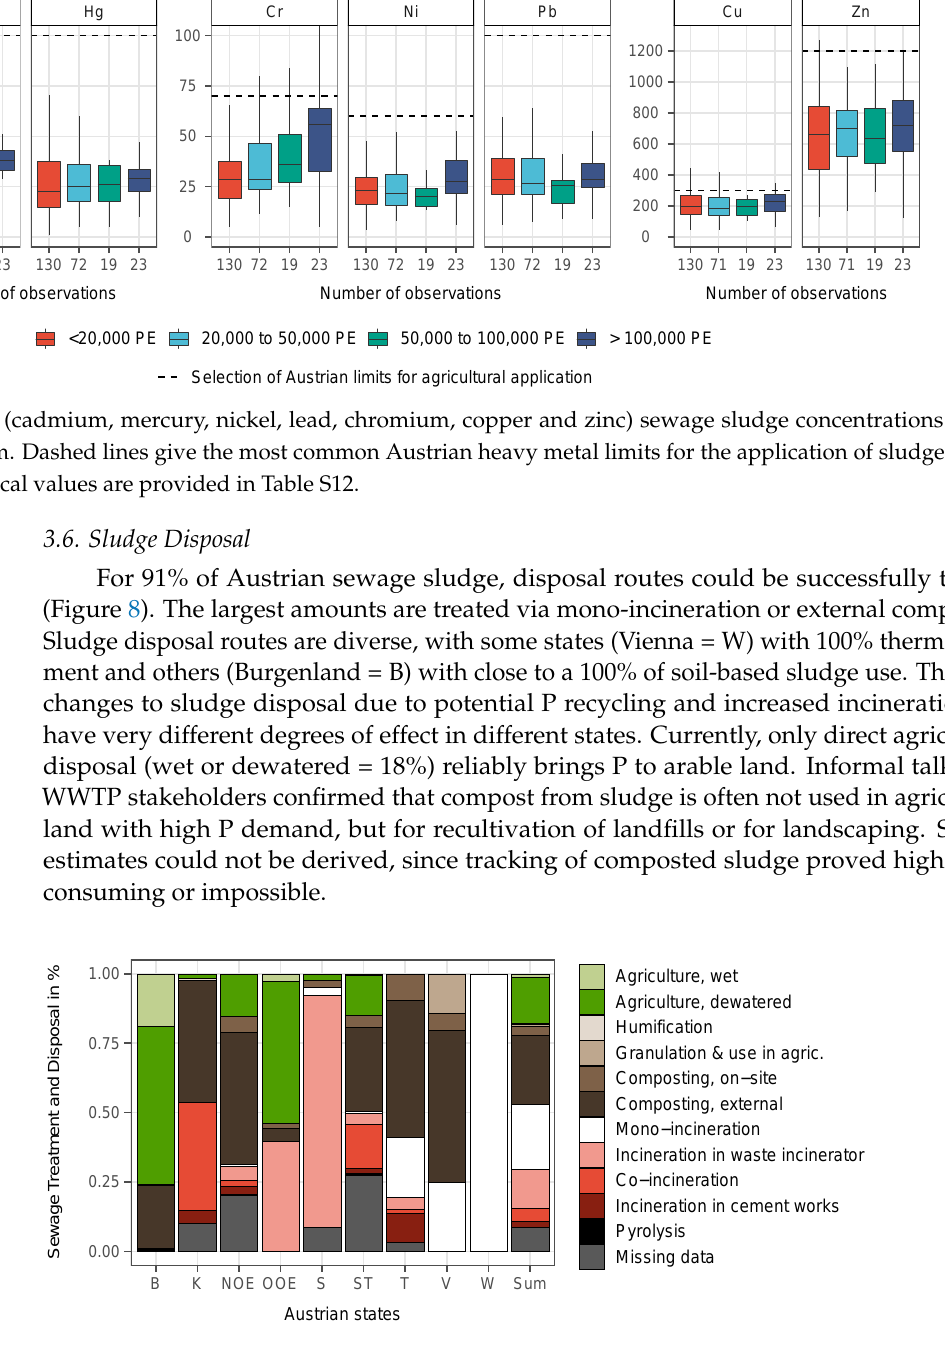
Figure 8. Sludge treatment and disposal routes in Austria in 2016 in % and for each federal state. Sludge disposal costs in 2016 ranged from 3.5 to 100 EUR t − 1 (wet mass) or 21 up to 560 EUR t − 1 (dry mass) (Figure 9). These are well in line with published sludge